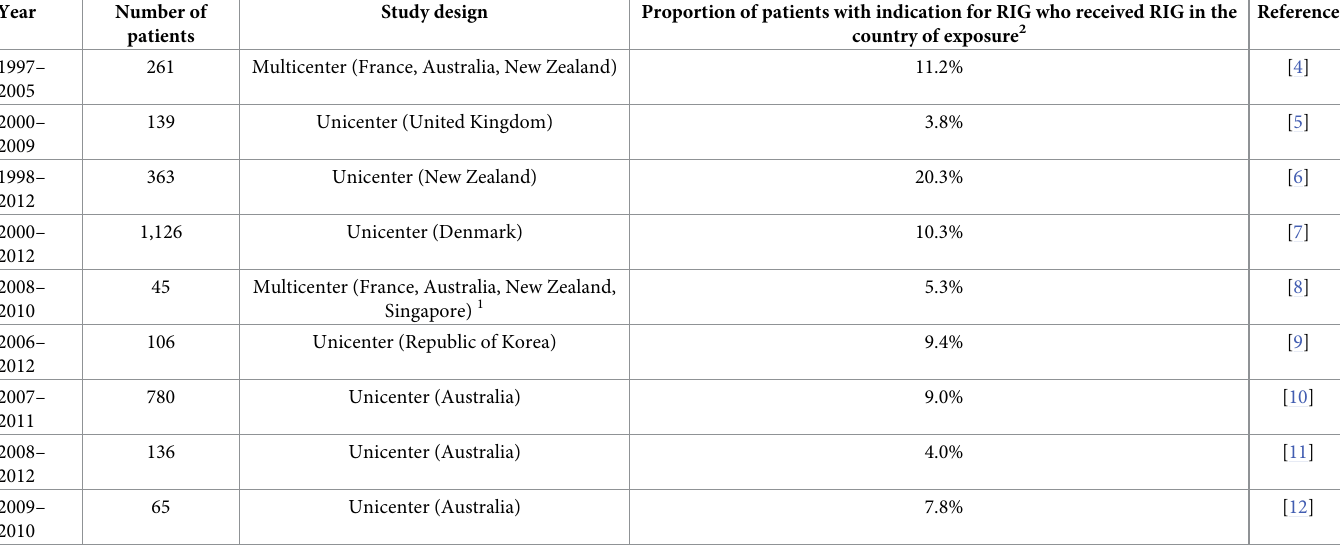
Table 1. Summary of studies showing proportion of patients with indication for rabies immunoglobulin who received rabies immunoglobulin in the country of exposure. Year Number of Study patients